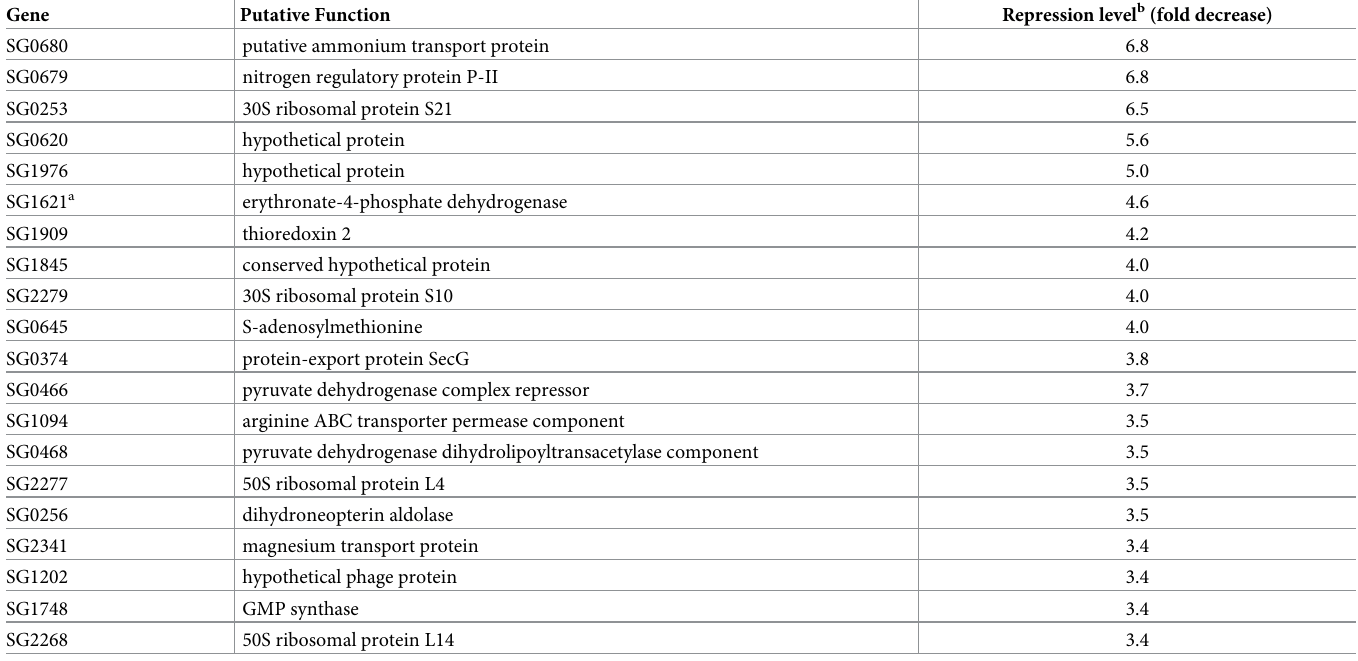
Table 3. Sodalis repressed induced genes (top